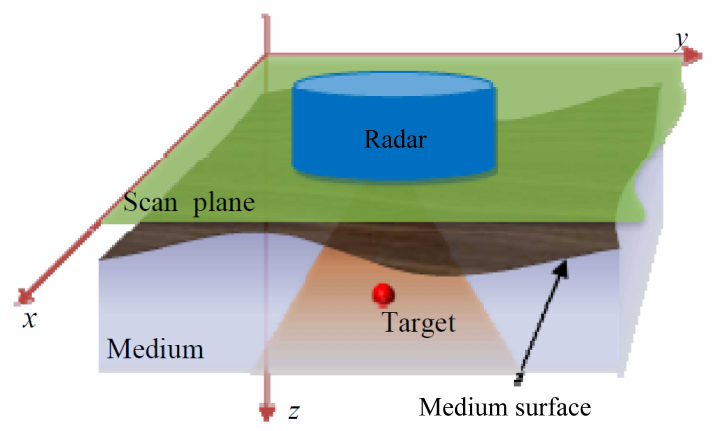
Figure 1. Geometry of holographic subsurface radar